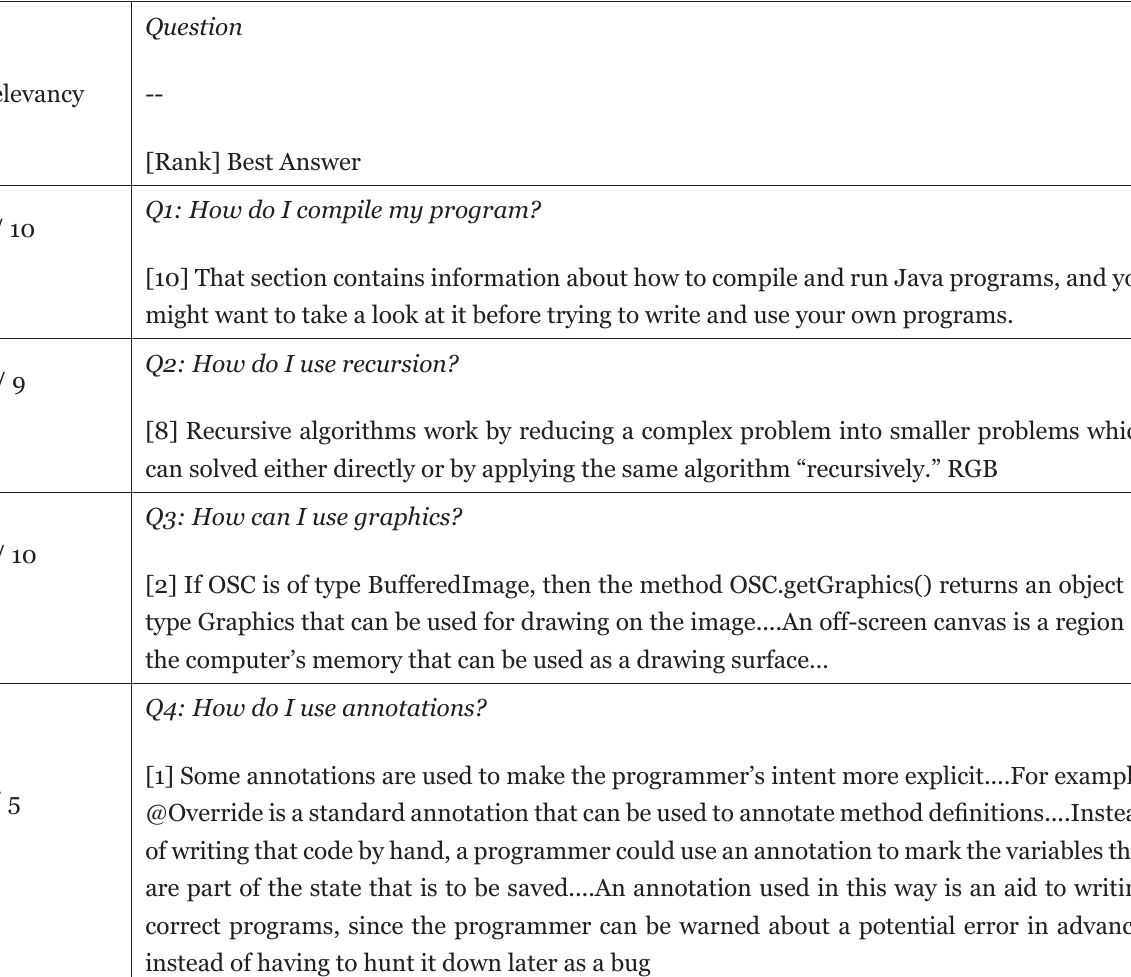
Commonly Asked Questions for an Introductory Course on Java